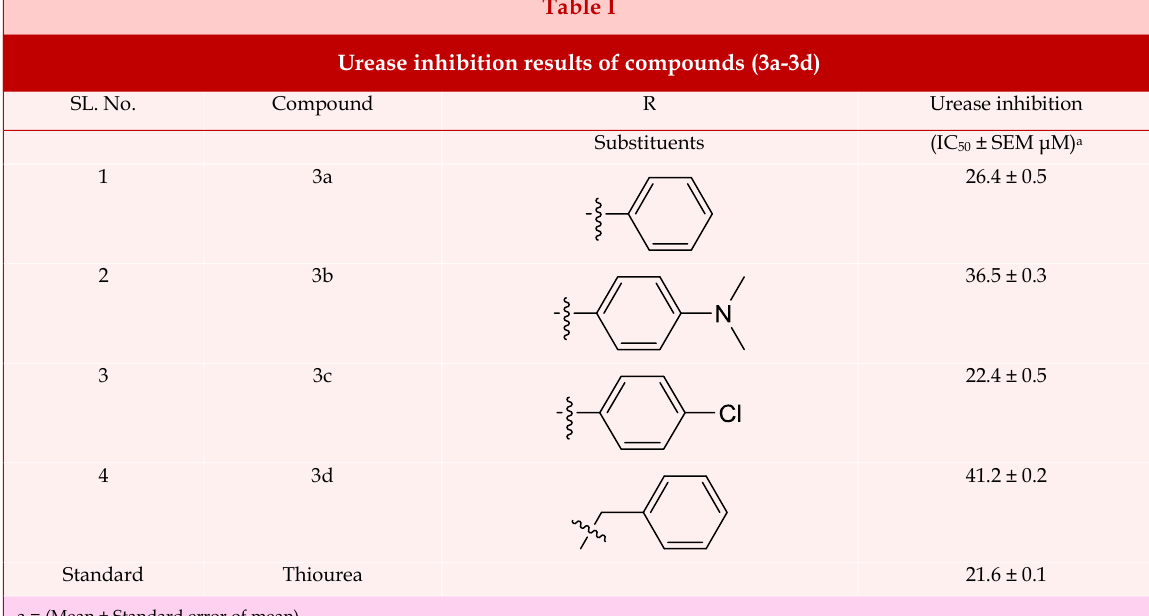
Urease inhibition results of compounds (3a-3d) SL.